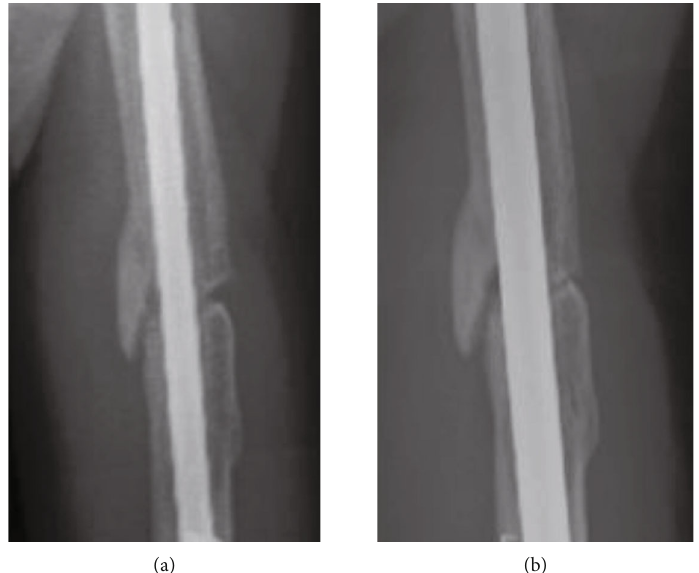
Figure 6: Radiographs comparing the gap before and after the nonunion surgery. (a) The gap before the surgery and (b) the gap after the surgery. It can be noted that the gap was reduced by